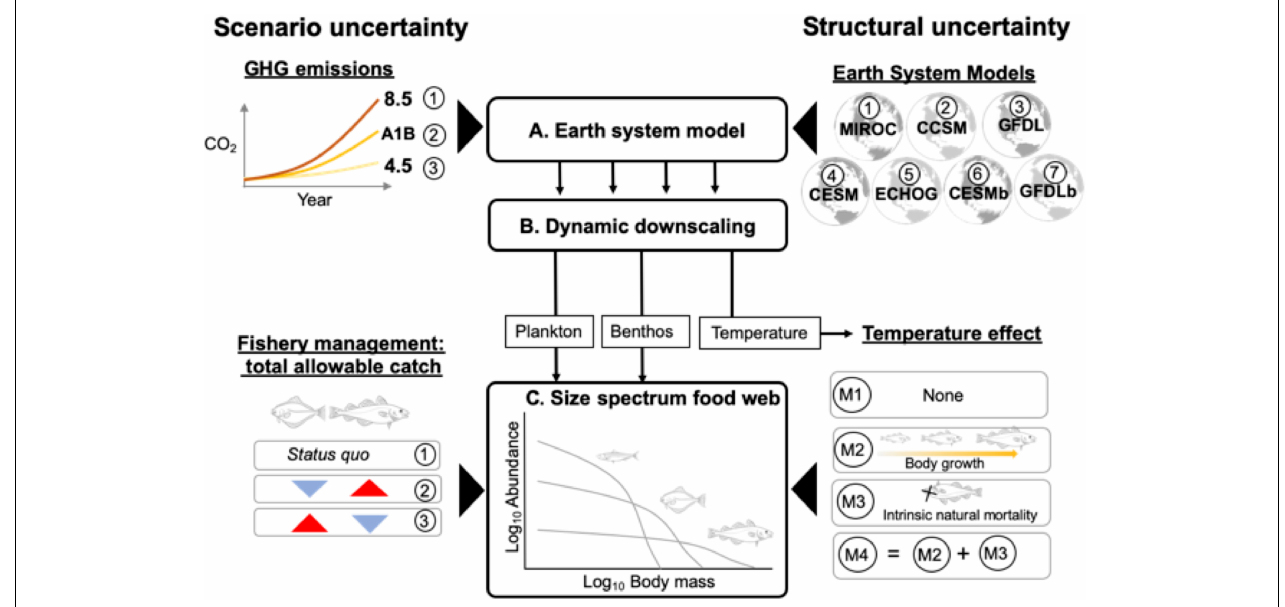
FIGURE 1 | Overview of modeling framework that links outputs from three model levels (A–C) to generate future projections of the eastern Bering Sea food web while incorporating different sources of uncertainty. (A) Multiple Earth System Models (ESMs) were forced under low (RCP 4.5), medium (SRES A1B), and high (RCP 8.5) future greenhouse gas emissions (GHG) scenarios. The ESM projections, in turn, were dynamically downscaled using (B) a regional biophysical model. Projections of temperature and plankton and benthos biomass were used to force (C) a multispecies size spectrum model. Structural uncertainty in projections arise from variability in model forcing parameters related to the different ESMs and hypotheses regarding temperature-dependences on body growth and mortality rates. Scenario uncertainty arises from different future GHG emission and fishery management scenarios that differ with respect to allocation of total allowable catch between flatfish and gadid